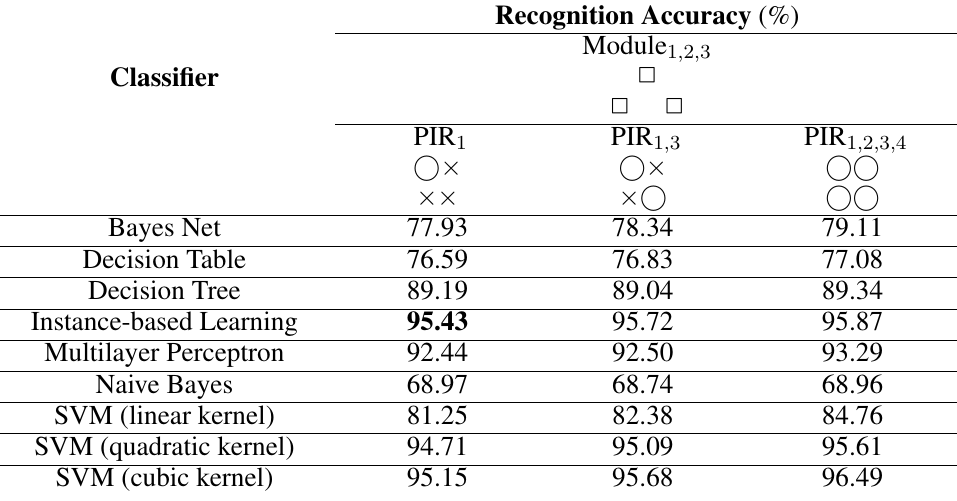
Table 5. Comparison of the recognition accuracy (%) of classifying walking speed levels based on the raw data set with respect to the number of PIR sensors of all modules.